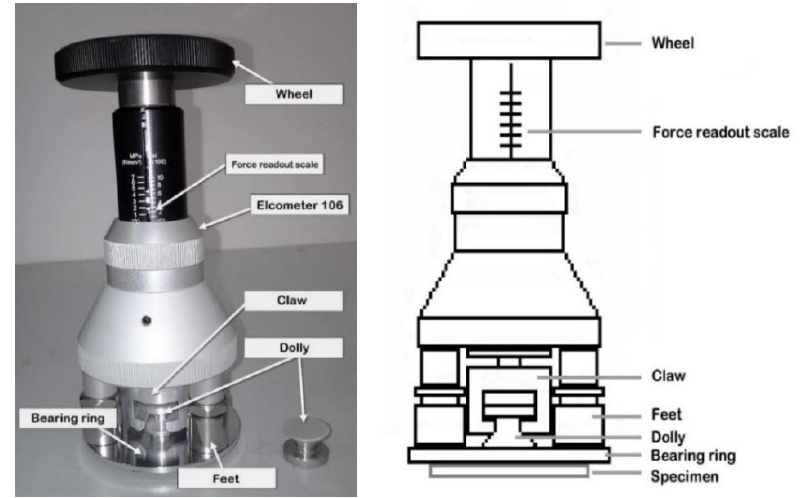
Figure 3. Elcometer 106 Pull Off Adhesion Tester.